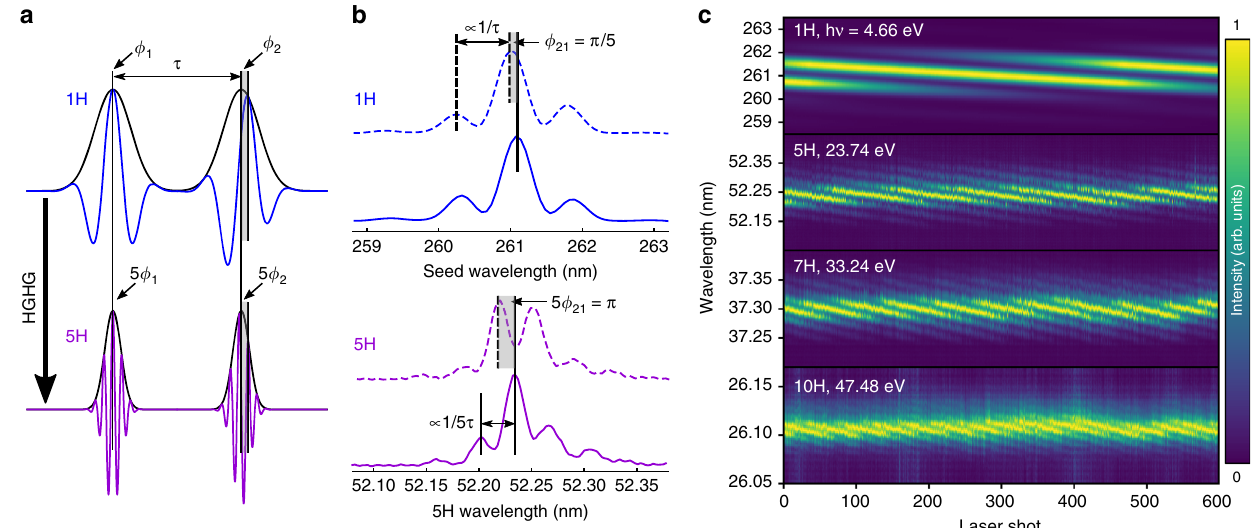
Fig. 2 XUV phase manipulation. a Scheme of timing and phase control of the XUV pulse pair (violet) by manipulation of the seed pulse (blue) parameters. In this scheme, manipulation of pulse delay τ and phase difference ϕ 21 = ϕ 2 − ϕ 1 are decoupled, in contrast to previous work 10,12,15 . b Demonstration of XUV phase control in Ramsey-type interference fringes for fi xed delay τ = 250 fs and two different phase values ϕ 21 recorded for the seed (blue) and its 5th harmonic (violet), respectively. The fringe spacing is inversely proportional to the pulse delay τ , while the fringe phase is directly proportional to the phase difference ϕ 21 . c Shot-to-shot phase manipulation of XUV pulses for different high harmonics for fi xed delay τ = 250 fs. Shown are Ramsey-type fringes of the seed (1H) and harmonic FEL pulses (5H – 10H). ϕ 21 was incremented by 15 mrad steps between each laser shot leading to a quasi-continuous phase sweep. Full phase rotations of several periods of 2 π are demonstrated without modi fi cation of τ . At the 10th harmonic, the spectrometer resolution is on the order of the fringe spacing, compromising the data quality slightly. All Ramsey-type fringes correspond to normalized single-shot events with no additional data processing